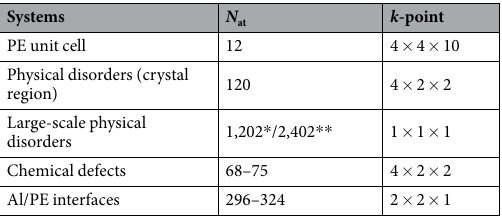
Table 4. Primary parameters, including the number of atoms N at and the k -point meshes, used for our calculations. * Lamella/amorphous region of PE; ** Semi-crystalline